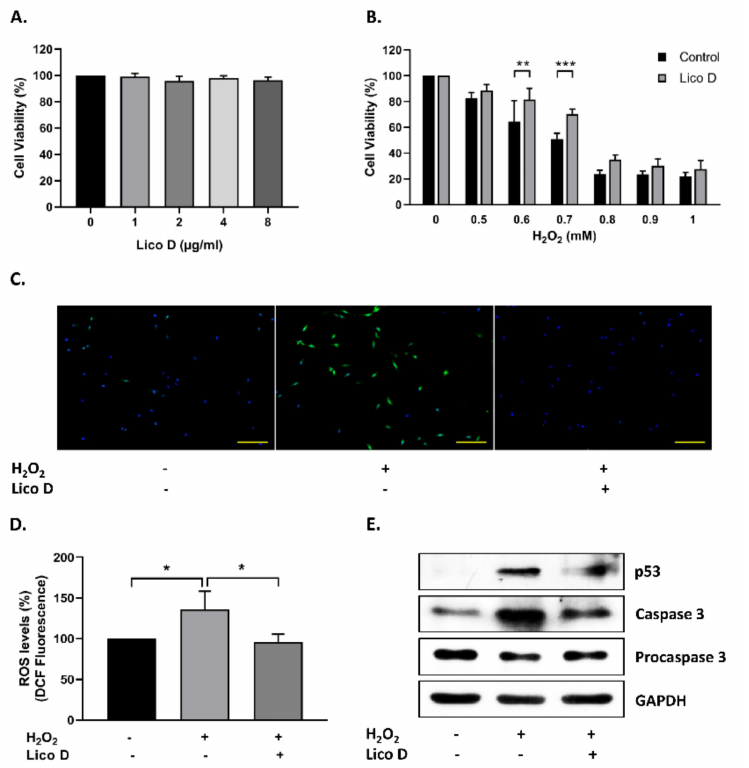
Figure 1. Protective effects of Licochalcone D (Lico D) against hydrogen peroxide (H 2 O 2 ). ( A ) Effect of Lico D on the cell viability was determined by MTT assay. ( B ) Protective effect of Lico D against H 2 O 2 was confirmed by MTT assay. ( C ) ROS scavenging activity of Lico D was determined by DCFH-DA fluorescence assay and ( D ) fluorescence intensity was quantified using Image J software. ( E ) Representative images from immunoblot assay against apoptotic markers such as procaspase 3, Caspase 3 (cleaved form) and p53. GAPDH was used as an internal control. The scale bar represents 100 µ m. All data are represented as the mean ± standard deviation (SD) ( n = 3) * p < 0.05, ** p < 0.01, and *** p <